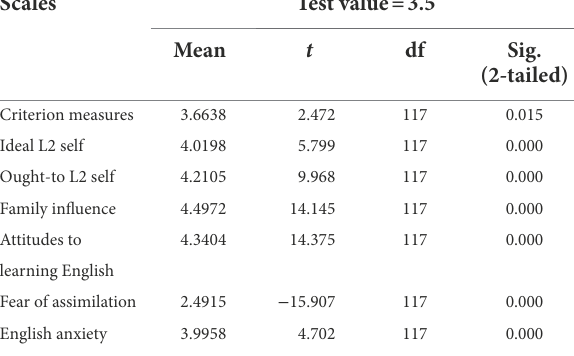
TABLE 2 Comparison of the mean of students’ responses to the 7 scales of questionnaire with the criterion value. Scales